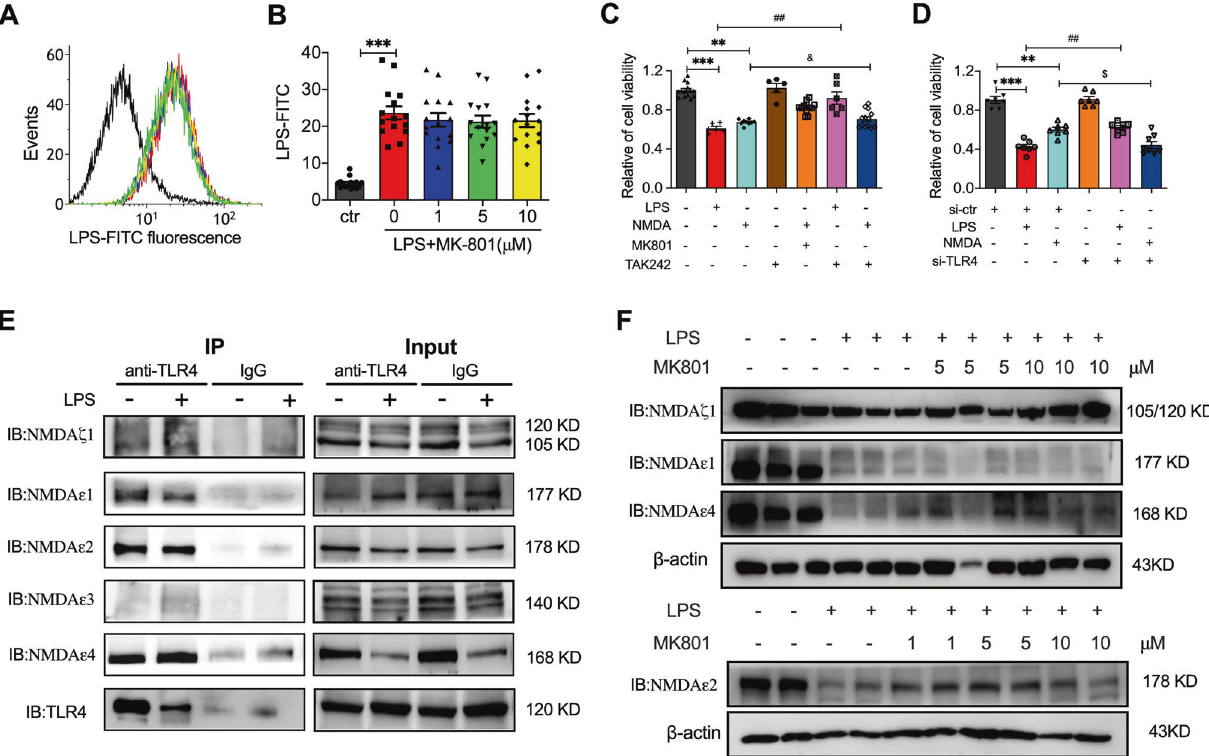
Fig. 5 The relationship between TLR4 and NMDARs. A Flow cytometry images and B analysis of FITC-conjugated LPS-treated HUVECs in the presence or absence of indicated doses of MK-801. C MTT assay showed relative cell viability in NMDA- or LPS-treated HUVECs in the presence or absence of MK801 or TAK242. D MTT assay showed relative cell viability in control siRNA or TLR4 siRNA transfected HUVECs treated with LPS or MK801. E Co-IP detection showed the interaction of NMDARs subunits, NMDA ζ 1, NMDA ε 1, NMDA ε 2, NMDA ε 3, and NMDA ε 4, with TLR4 induced by LPS in HUVECs. F The western blotting image showed the expression of NMDA ζ 1, NMDA ε 1, NMDA ε 2, and NMDA ε 4 treated with LPS in the presence or absence of different concentrations of MK801 in HUVECs. (Data are presented as mean ± SEM, *** P < 0.001, ** P < 0.01 vs. Control or control siRNA; ## P < 0.01 vs. LPS or control siRNA + LPS; & P < 0.05 vs. NMDA; $ P < 0.05 vs . TLR4